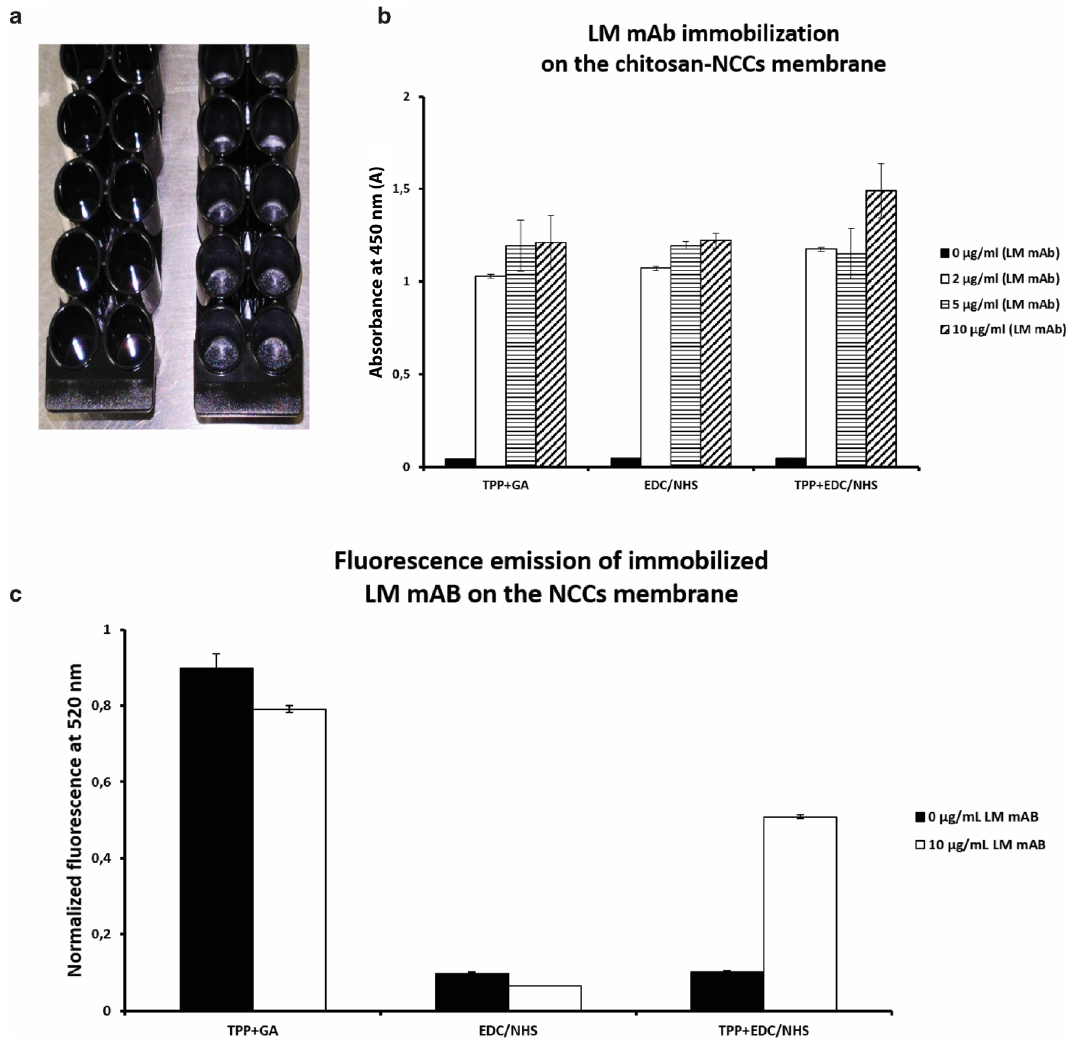
Figure 4. Multiwell microplate preparation: CNC membrane deposition and immobilization of capture antibody. (a) F16MOD microplate details: left side—clean wells and right side—CNC membrane coated wells. (b) Absorbance emission at 450 nm for the different LM mAb immobilization protocols performed. The best immobilization was been obtained at 10 mg/mL of monoclonal IgG, following protocol number two. (c) Normalized background fluorescence emission of each performed